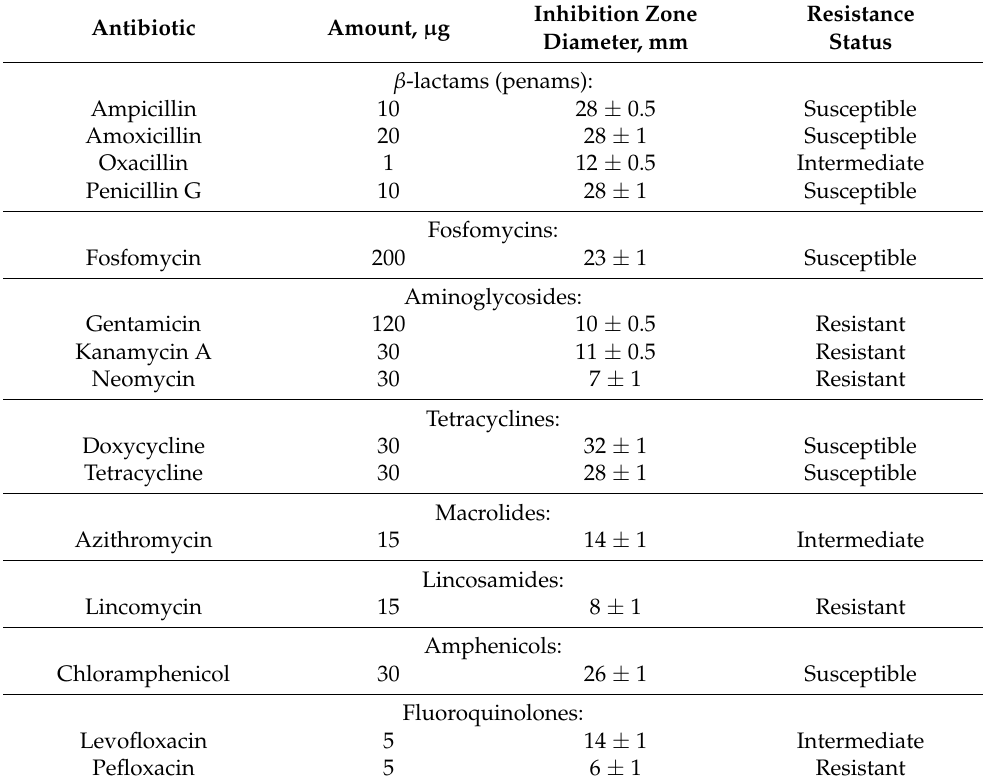
Table 1. The antibiotic resistance profile of B. longum